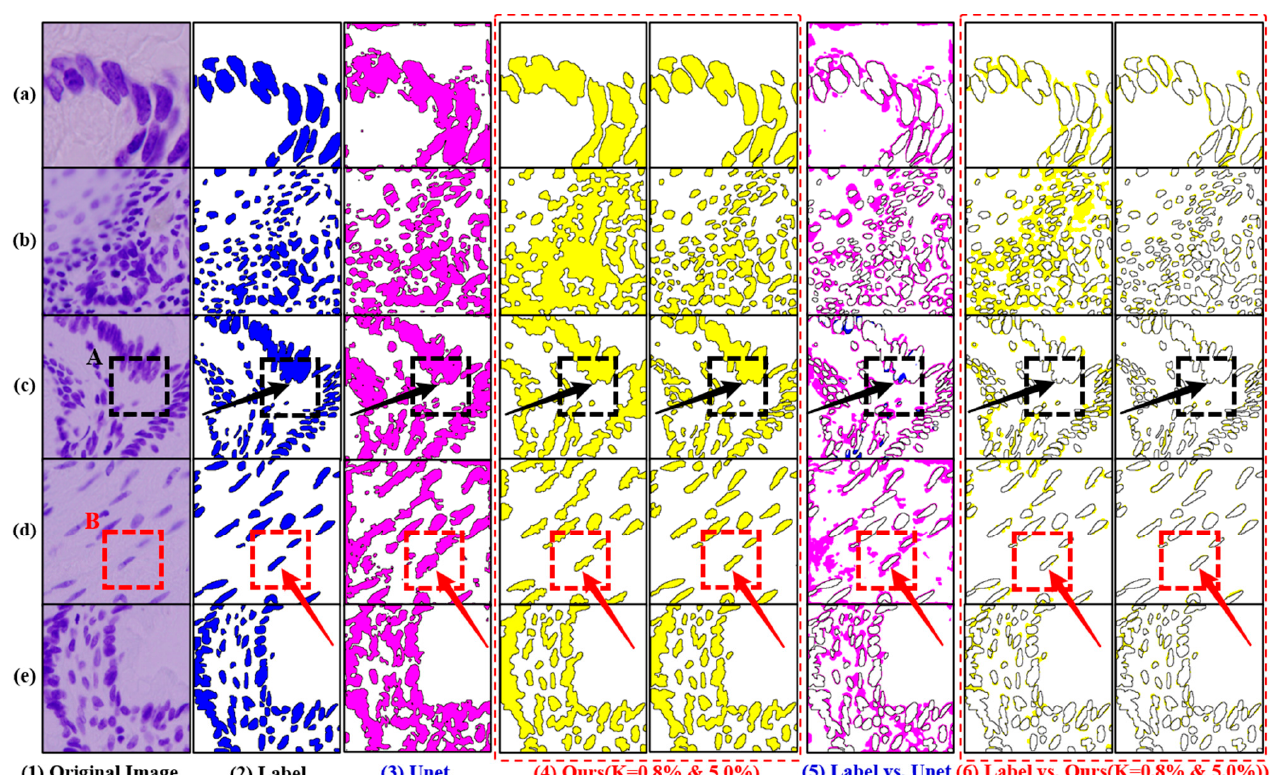
Figure 9. The results from the Unet and the OISM methods in typical samples: ( 1 ) ( a – e ) are five cell images selected for semantic segmentation; ( 2 ) denotes five true labeled images; ( 3 ) indicates the segmentation results of Unet; ( 4 ) is the segmentation results with the OISM at K = 0.8% and K = 5.0%; ( 5 ) and ( 6 ) are the relationships among the true labeled images, Unet segmentation images, and the OISM images; A is the area of dashed red box where compare the results of inside cells segmentation; B is the area of dashed black box where compare the results of outside cells